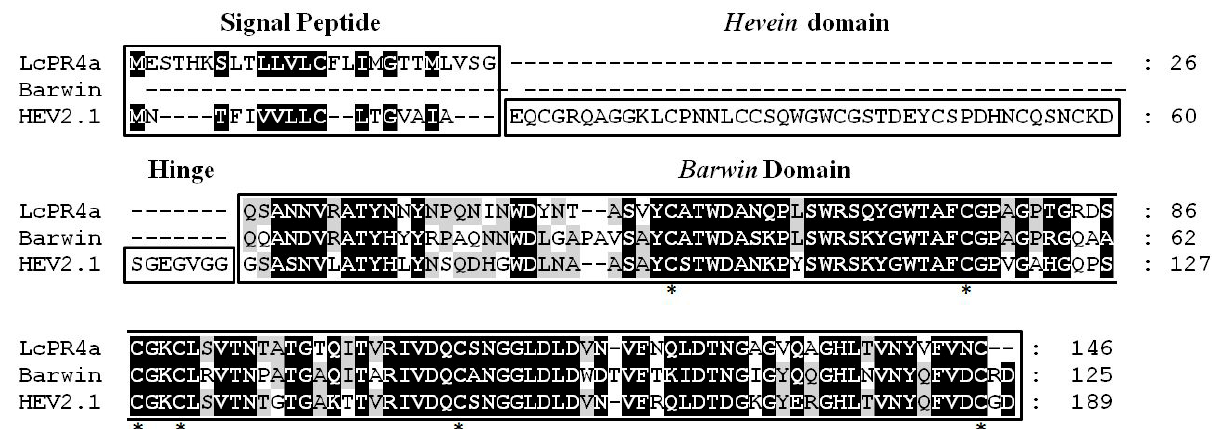
Figure 1. Alignment of the amino acid sequence of deduced LcPR4a with barwin (P28814) and HEV2.1 (AAO63573) show - ing the presence of Barwin but lack of Hevein domain in LcPR4a. Numbers correspond to the last amino acid position. Black and shaded backgrounds indicate identical and similar amino acids. The six cysteines conserved in the Barwin fam - ily of proteins are marked with asterisks. Sequences were aligned in ClustalW and visualised in